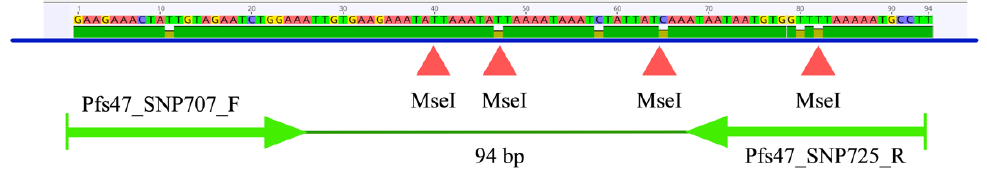
Figure 1. 94 bp fragment of the pfs47 gene indicating the primer target sites and four MseI cutting points.